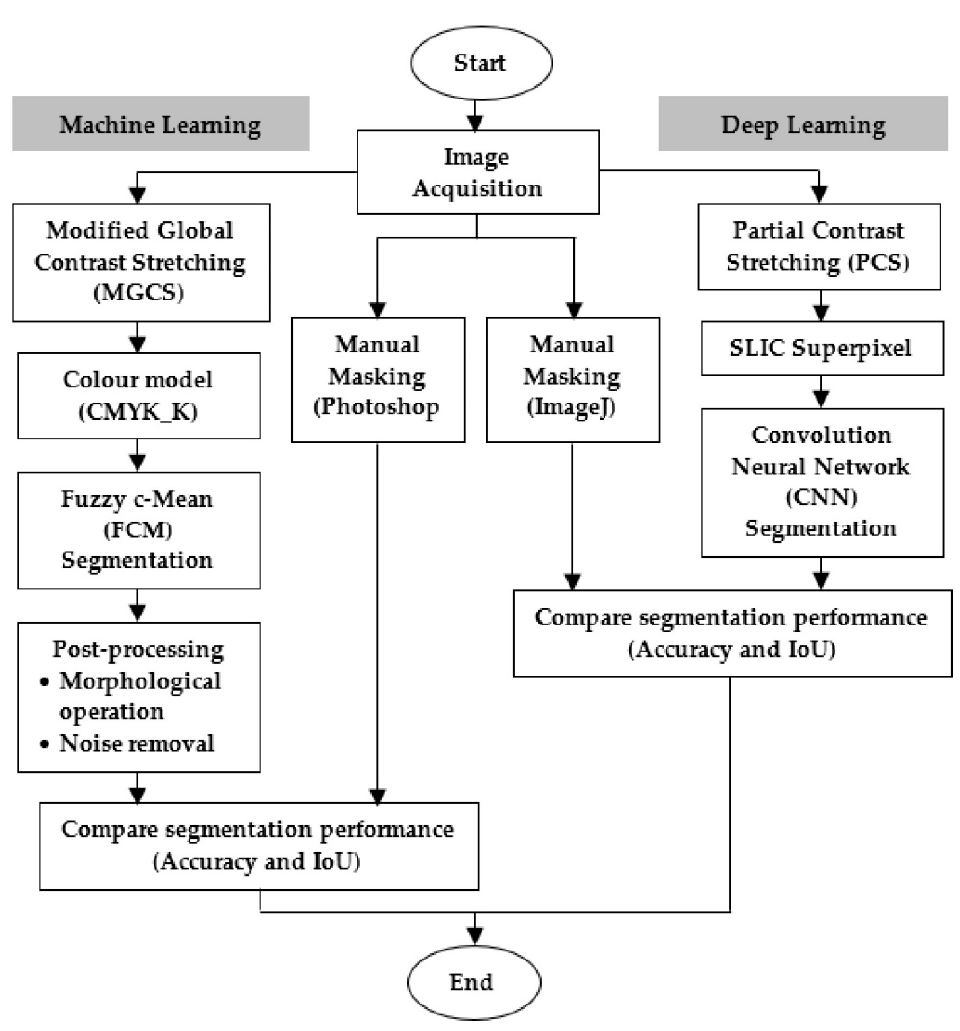
Figure 1. Flow chart for the techniques proposed for machine learning and deep learning segmen- tations.